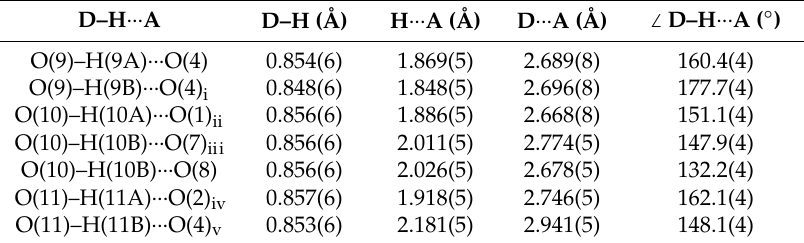
Table 5. The O–H ··· O hydrogen bonds for 2 1